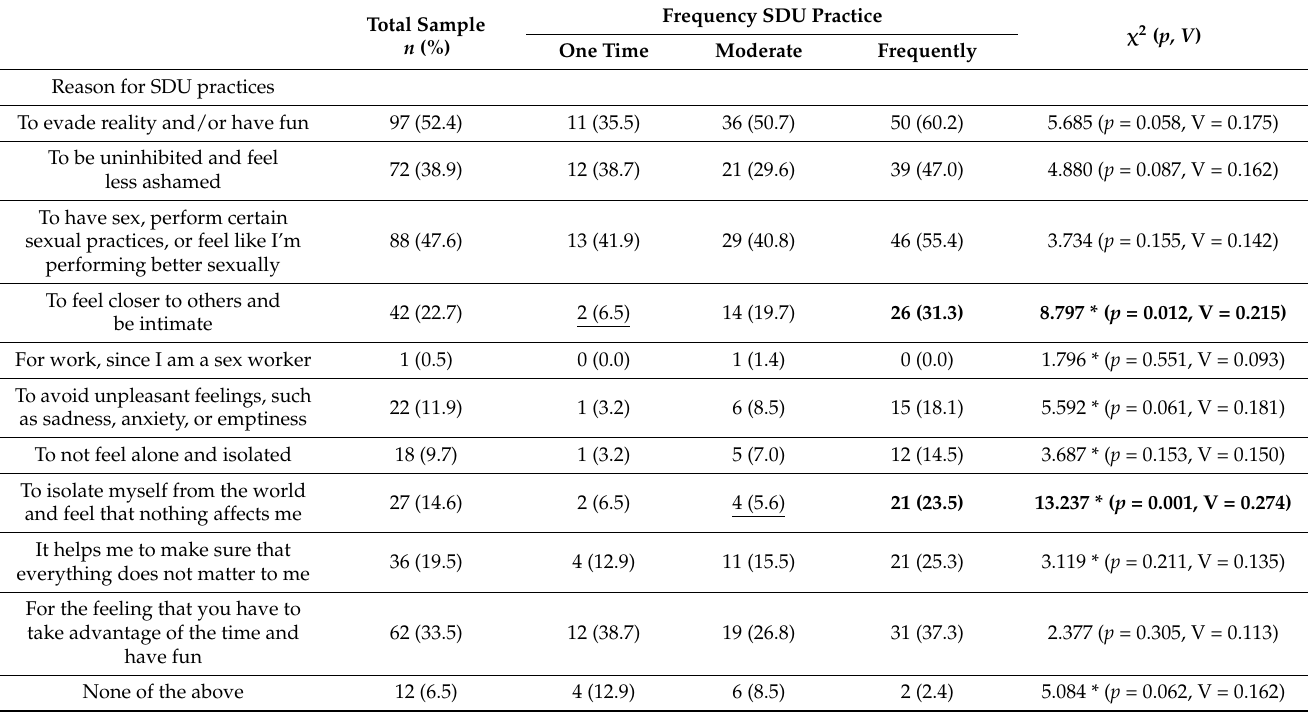
Table 2. The Reasons and Moments/Situations Favored for Practicing